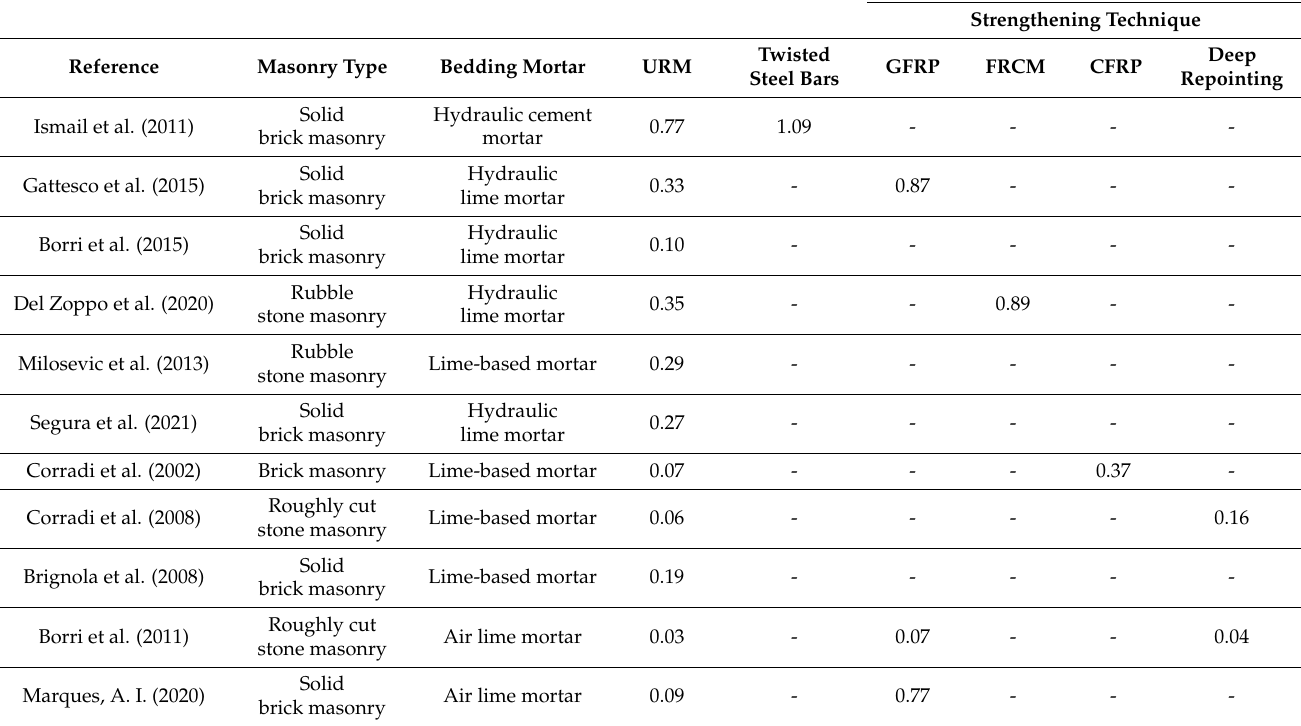
Table 1. Shear strength through diagonal compression test of URM and strengthened masonry walls in literature